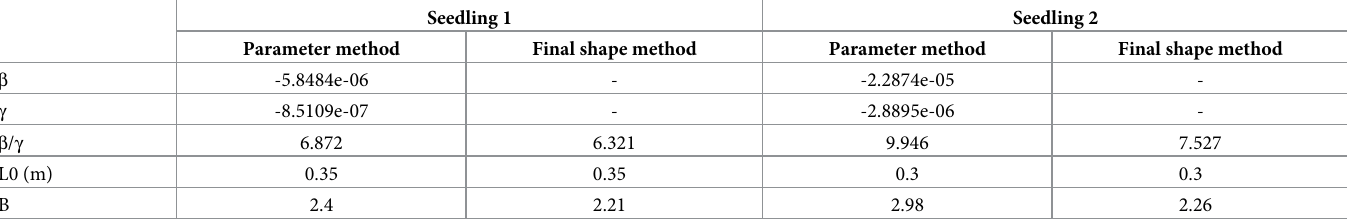
Table 1. Values of gravitropic ( β ) and proprioceptive ( γ ) sensitivities (SI unit) and B determined with AC model phenotyping with the “parameter model method” and the “final shape method” in the radially growing zone of the stem (i.e., stem with the exception of the annual shoot).